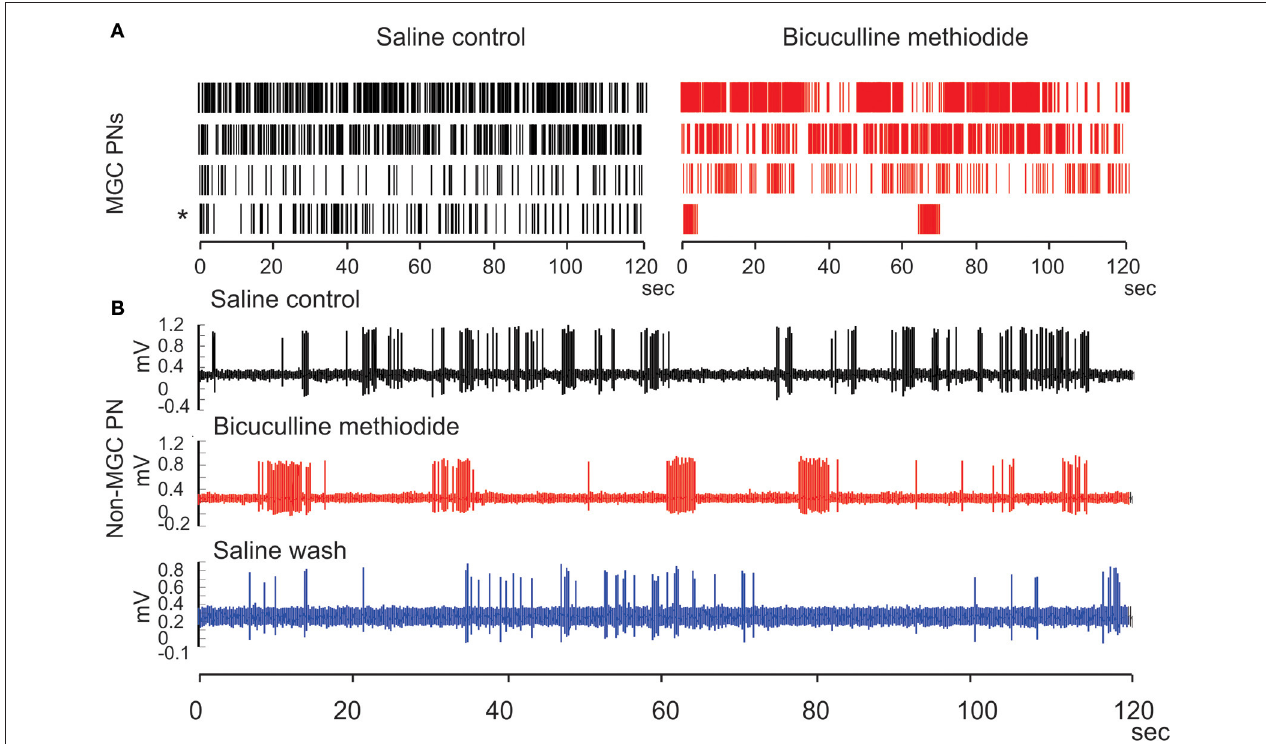
FIGURE 12 | Bicuculline methiodide (BIC) alters the spiking patterns of the spontaneous activity of PNs both in the MGC and in the ordinary glomeruli. (A) Raster plots show that BIC treatment generally increases the spontaneous activity level of MGC PNs, opposite to the picrotoxin treatment, and produces the run-away pattern (asterisk) in some PNs. (B) Such run-away patterns are also present outside the MGC when BIC is used, verifying the predictions from the network